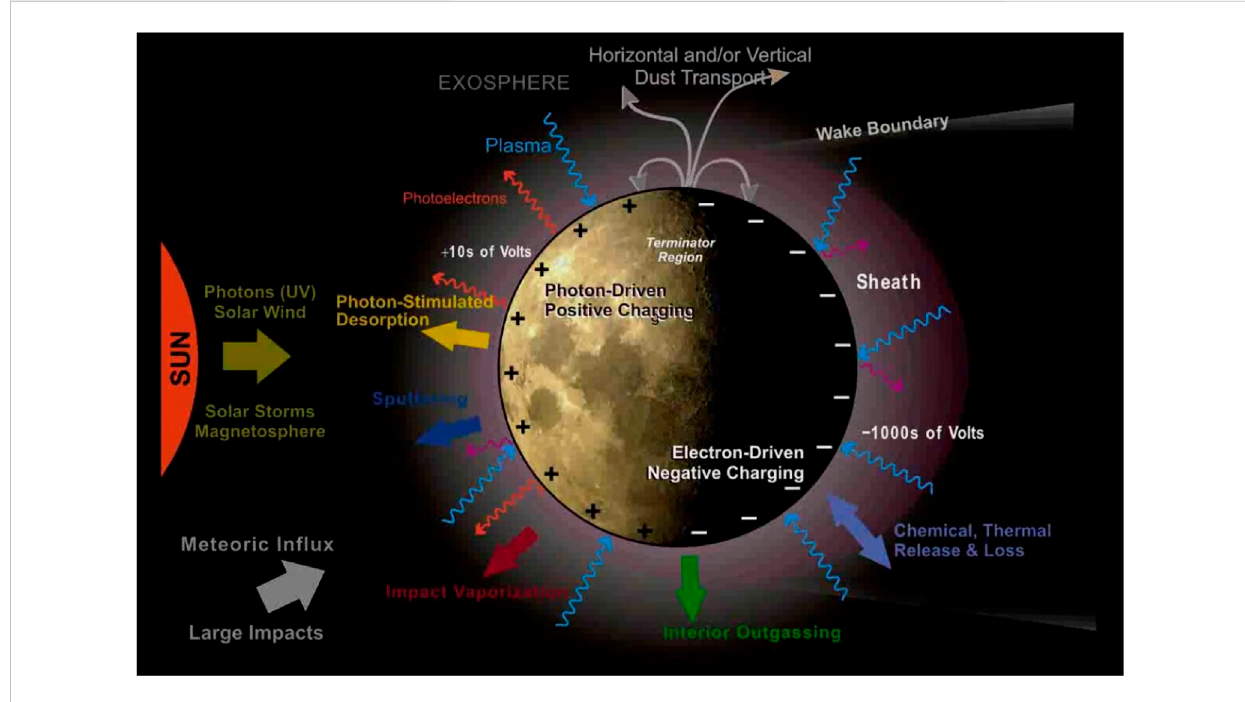
FIGURE 2 Moon ’ s environment with the complex interaction between solar radiation, space plasma, meteoritic fl ux, dust, exosphere and the surface (Credit: Jasper